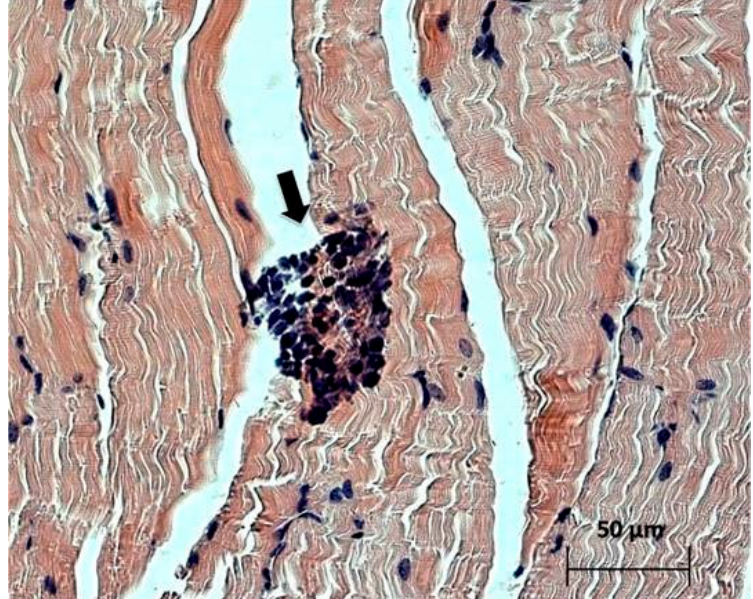
Figure 3. Individual tumor islets (indicated by an arrow) of Krebs-2 carcinoma in the muscle tissue of a mouse receiving a series of intratumoral NDV/Altai/pigeon/770/2011 injections with almost complete tumor regression in MRI. Day 20 after virotherapy (day 28 of tumor growth), hematoxylin-eosin staining.